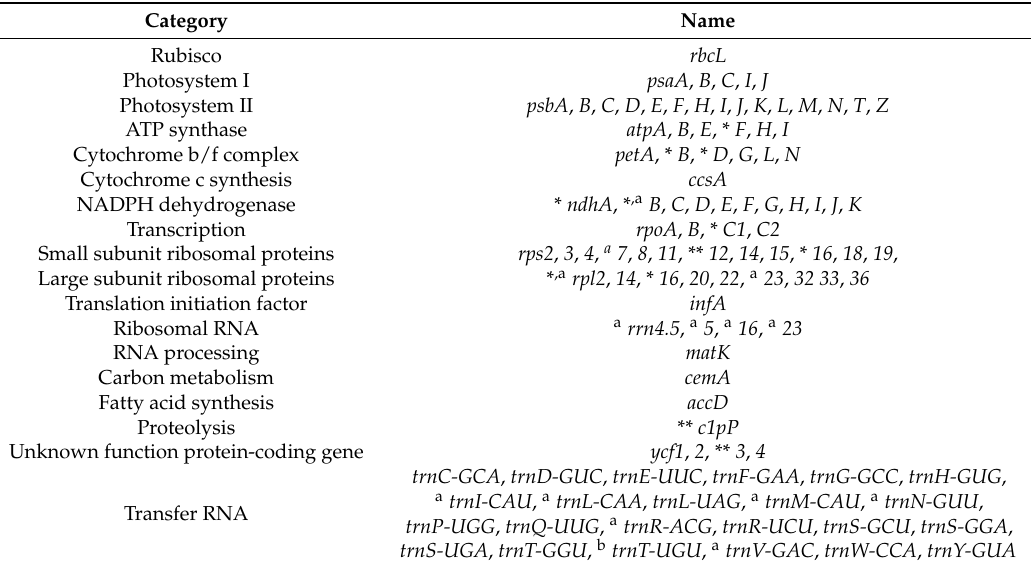
Table 2. Genes present in Lancea tibetica and L. hirsuta chloroplast genomes. Category